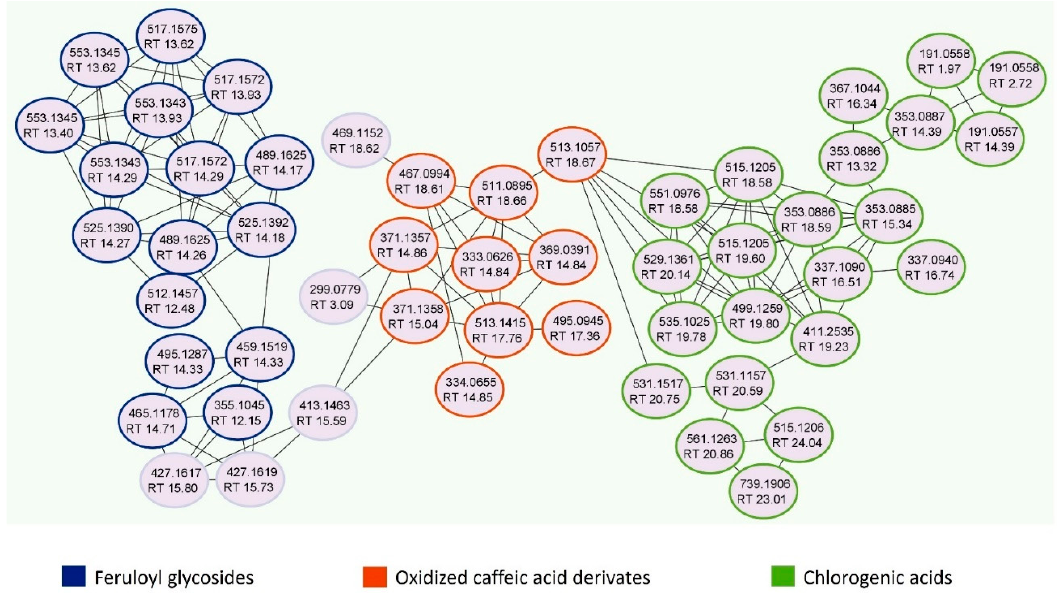
Figure 2. Molecular networks (MNs) showing the presence of chlorogenic acids, oxidized caffeic acid derivates and feruloyl glycosides in JasHEx.